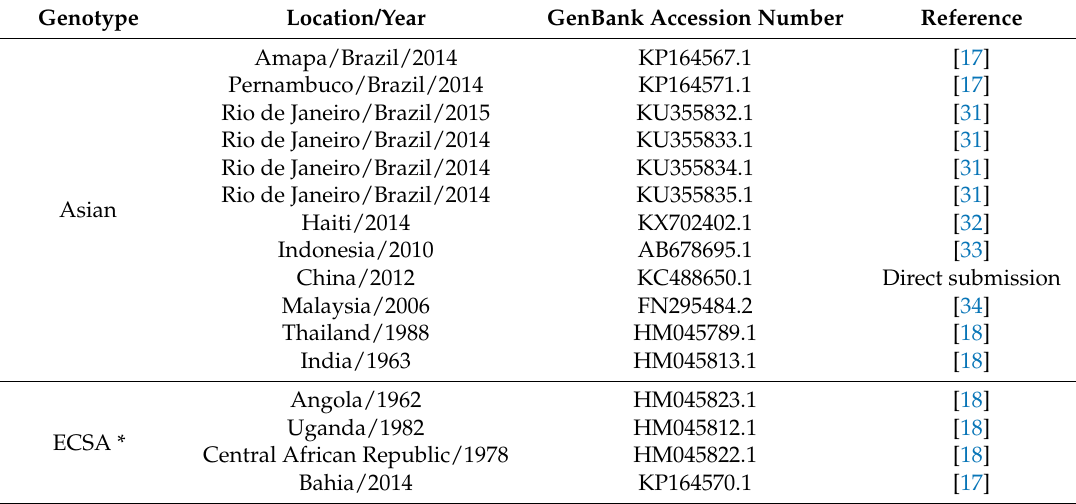
Table 1. GenBank available sequences used for phylogenetic analysis representative of the